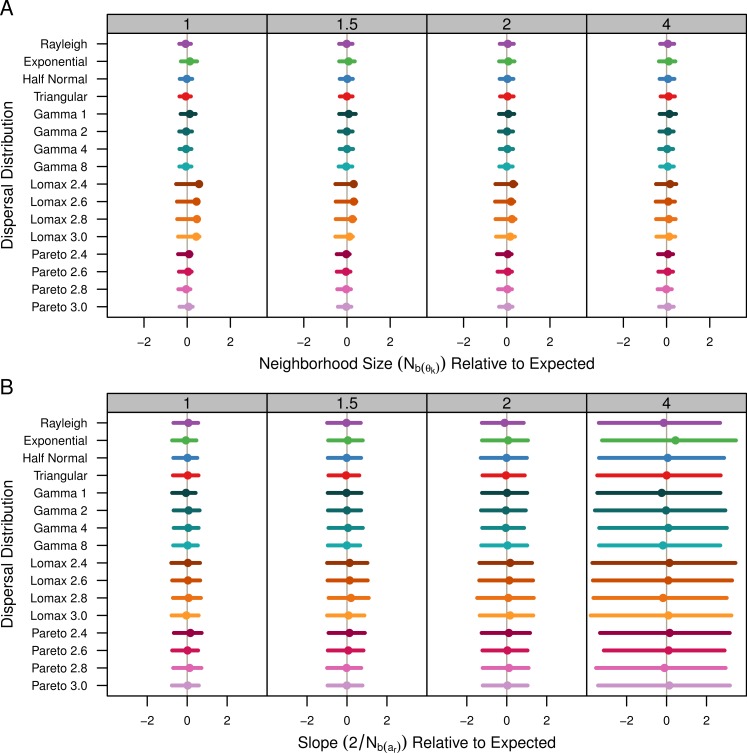
Estimated neighborhood sizes are similar across all dispersal distributions.Neighborhood size is estimated two different ways. (A) Nb(θk) is \documentclass[12pt]{minimal}
\usepackage{amsmath}
\usepackage{wasysym}
\usepackage{amsfonts}
\usepackage{amssymb}
\usepackage{amsbsy}
\usepackage{upgreek}
\usepackage{mathrsfs}
\setlength{\oddsidemargin}{-69pt}
\begin{document}
}{}$4\pi {s}^{2}{\hat {D}}_{e}$\end{document}4πs2D ˆe where \documentclass[12pt]{minimal}
\usepackage{amsmath}
\usepackage{wasysym}
\usepackage{amsfonts}
\usepackage{amssymb}
\usepackage{amsbsy}
\usepackage{upgreek}
\usepackage{mathrsfs}
\setlength{\oddsidemargin}{-69pt}
\begin{document}
}{}${\hat {D}}_{e}$\end{document}D ˆe is estimated from \documentclass[12pt]{minimal}
\usepackage{amsmath}
\usepackage{wasysym}
\usepackage{amsfonts}
\usepackage{amssymb}
\usepackage{amsbsy}
\usepackage{upgreek}
\usepackage{mathrsfs}
\setlength{\oddsidemargin}{-69pt}
\begin{document}
}{}${\hat {\theta }}_{k}$\end{document}θ ˆk. The dot is the average from all populations samples and the bars represent the middle 50% of estimates from individual samples. (B) The slope estimates, \documentclass[12pt]{minimal}
\usepackage{amsmath}
\usepackage{wasysym}
\usepackage{amsfonts}
\usepackage{amssymb}
\usepackage{amsbsy}
\usepackage{upgreek}
\usepackage{mathrsfs}
\setlength{\oddsidemargin}{-69pt}
\begin{document}
}{}$ \frac{2}{{N}_{b(ar)}} $\end{document}2Nbar, of ar and the log of distance. The dots represent the slope estimate from the combined data from all samples and the bars represent the middle 50% of slopes from individual samples.